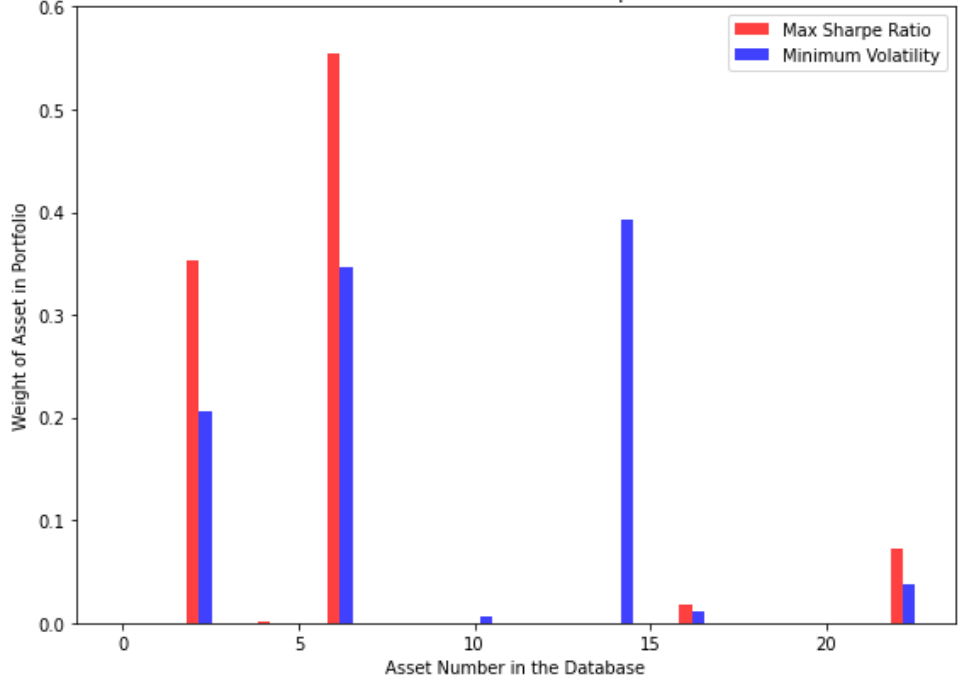
Figure 27. COVID-19 Wave II—Portfolio optimization: Weights and Sharpe ratios. Hence, assets that stand out in asset selection are the Swiss Franc (as a refuge for value) and Chinese stocks (similar to phase I). Mexican and Argentinian stocks can be re-sold to buy U.S. stocks. The geographical re-location of the portfolio implies moving from South America to North America whilst maintaining the allocation towards China. Short- to long-term U.S. bonds are maintained in all portfolios for a safe